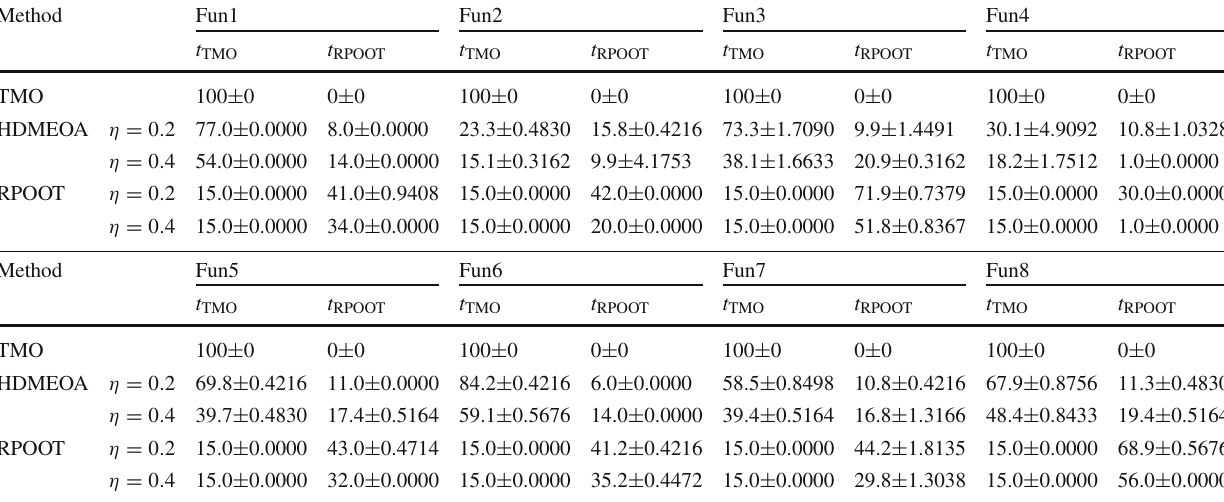
Table 11 NumTR comparison of three methods under stochastic environmental changes